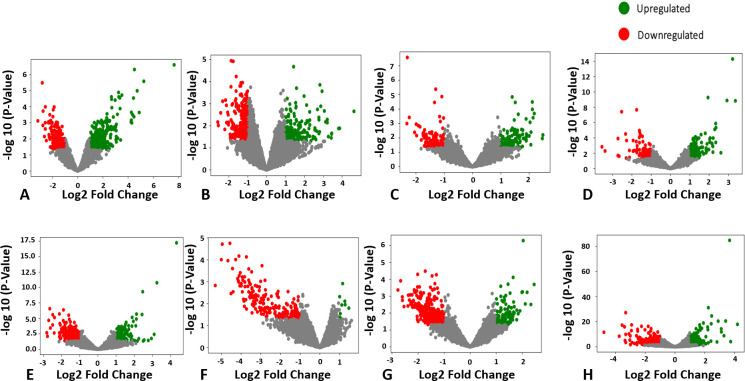
Volcano plots.Genes upregulated (green) or downregulated (red) by WE consumption, correspond to a 1.5 decrease or increase in log fold changes. Each panel corresponds to a tissue in a given genotype: A) lean adipose; B) lean PFC; C) lean kidney; D) lean liver; E) ZDF adipose; F) ZDF PFC; G) ZDF kidney; and H) ZDF liver.